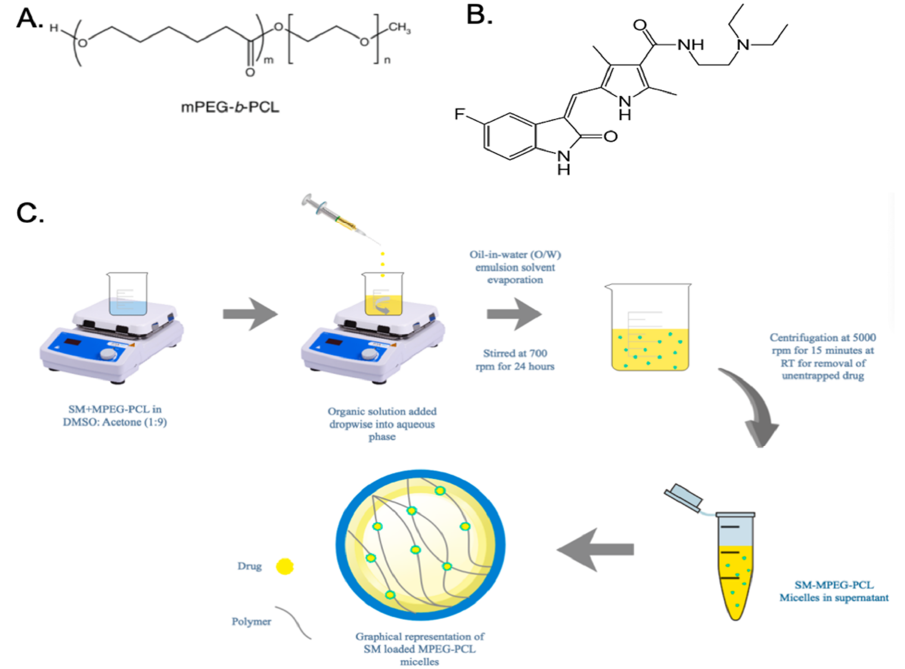
Figure 1. ( A ) Structure of the ((methoxypoly(ethylene glycol) poly(caprolactone)) (MPEG-PCL) polymer, ( B ) the structure of sunitinib, and ( C ) the preparation scheme for the sunitinib malate (SM)-MPEG-PCL